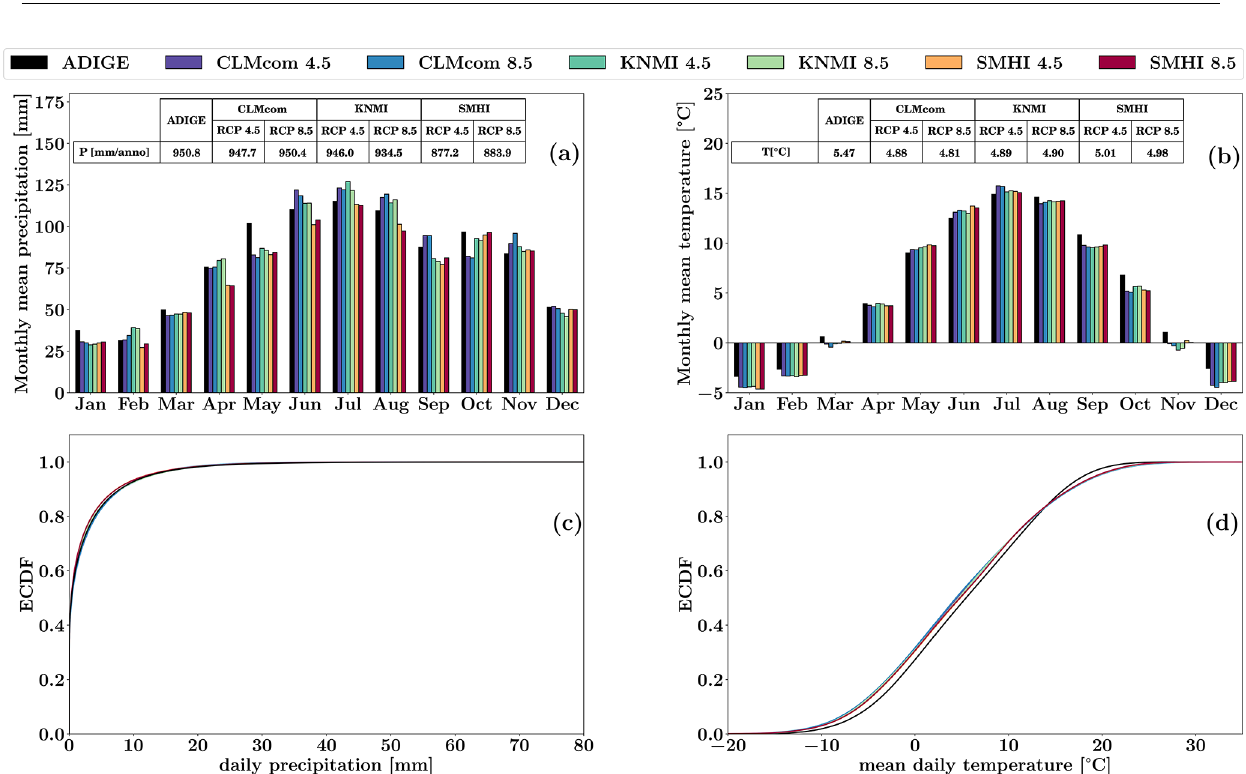
Figure 2. Annual cycle of basin-averaged monthly mean precipitation (a) and temperature (b) during the reference period (1980–2010) for both ADIGE and the six CMs used (different colored bars). The associated annual averages are also shown in the insets. ECDFs of basin-averaged daily precipitation and temperature for the same datasets are presented in subplots (c) and (d) ,